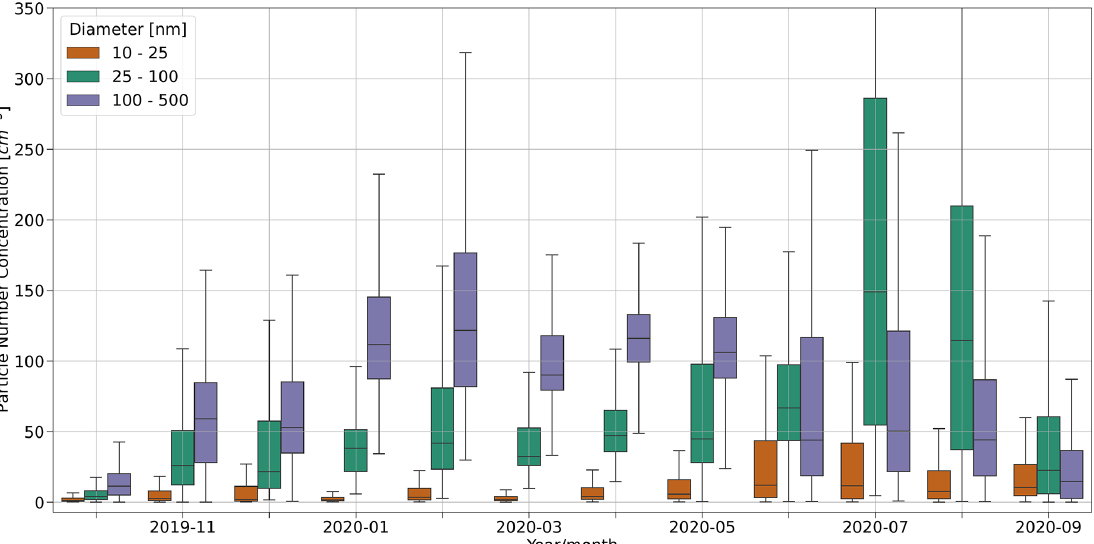
Figure 6. The annual cycle in the PNC during MOSAiC in different size ranges. The box plots represent the PNC as monthly medians of the integrated SMPS data after the removal of local pollution sources. The size ranges are defined as 10–25nm (nucleation mode, orange), 25–100nm (Aitken mode, green), and > 100nm (accumulation mode,